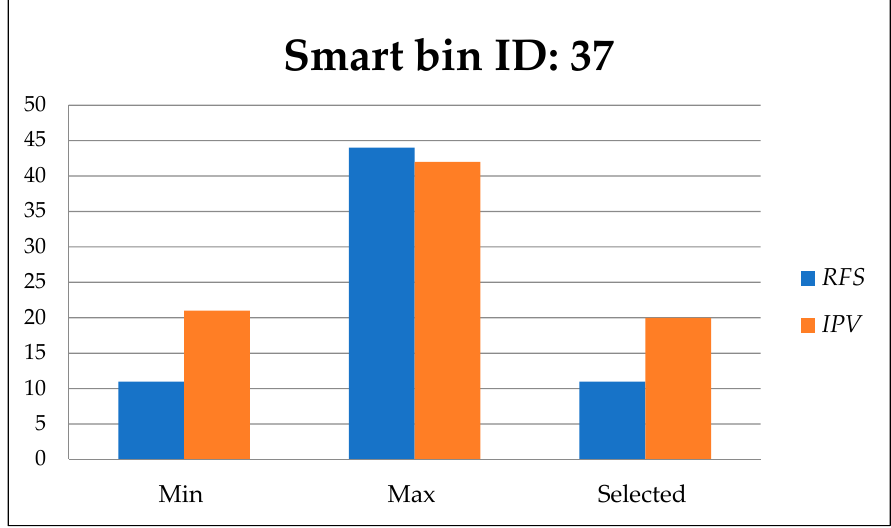
Figure 15. Residual free space R fs , and importance priority value IPv to smart bin id: 37.